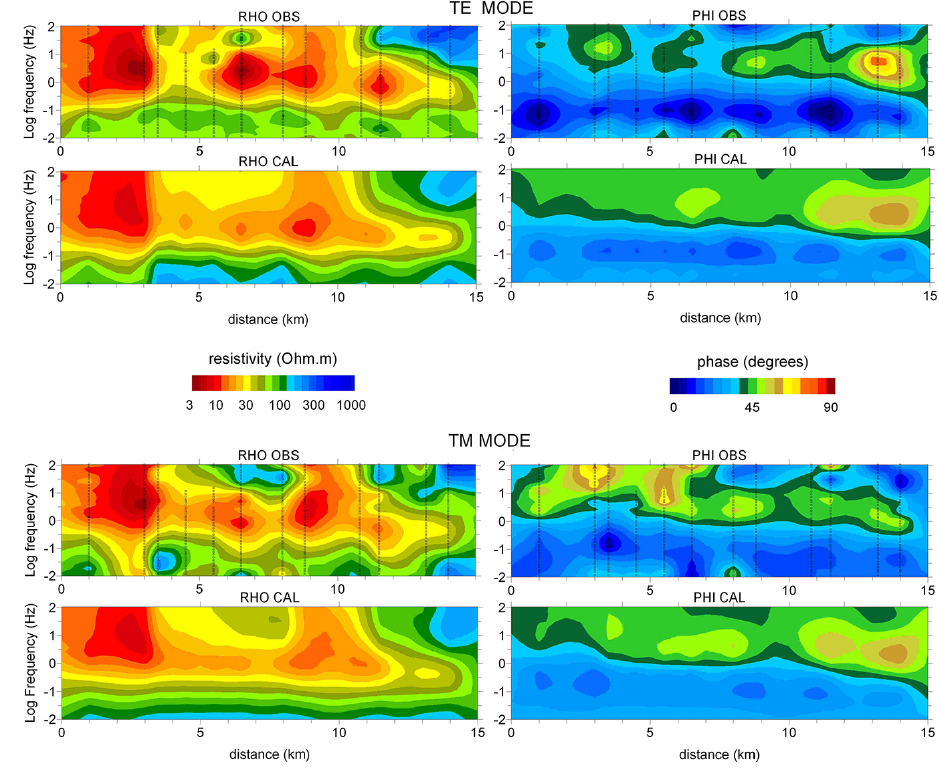
Figure 4. Apparent resistivity and phase pseudosections for the observed (OBS) and calculated (CAL) data of the MT profile reported in Fig. 1. The dot lines indicate the positions of the MT stations.